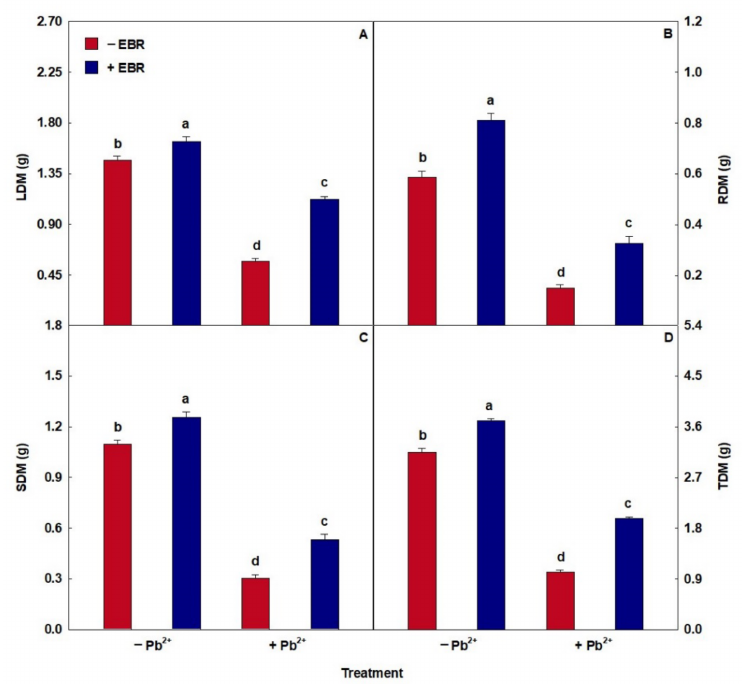
Figure 5. ( A ) Leaf dry matter (LDM), ( B ) root dry matter (RDM), ( C ) stem dry matter (SDM), and ( D ) total dry matter (TDM) in tomato plants treated with 24-epibrassinolide (EBR) and subjected to lead (Pb) toxicity. Columns with different letters indicate significant differences from the Scott–Knott test ( p < 0.05). Means ± SD, n =